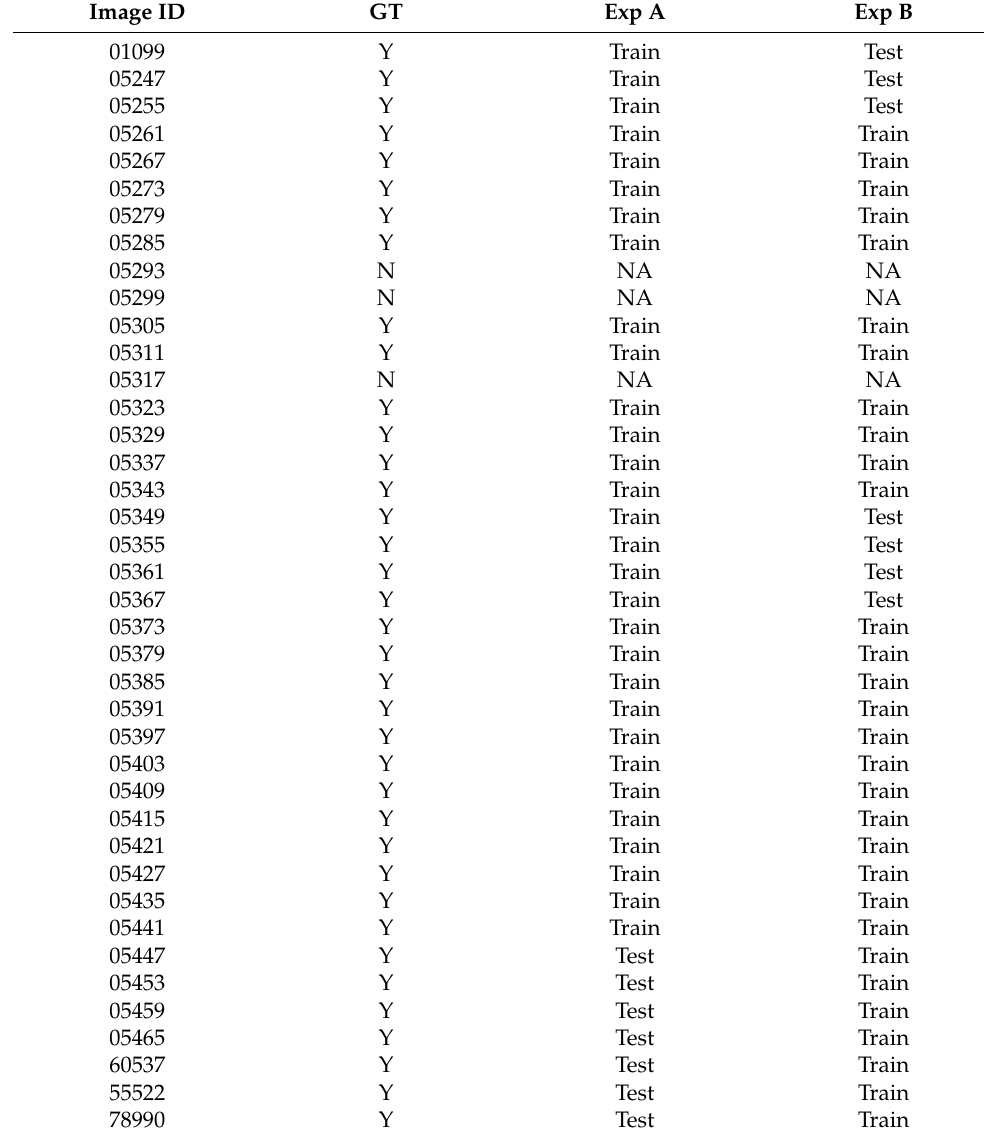
Table 2. Summary of the images used in the